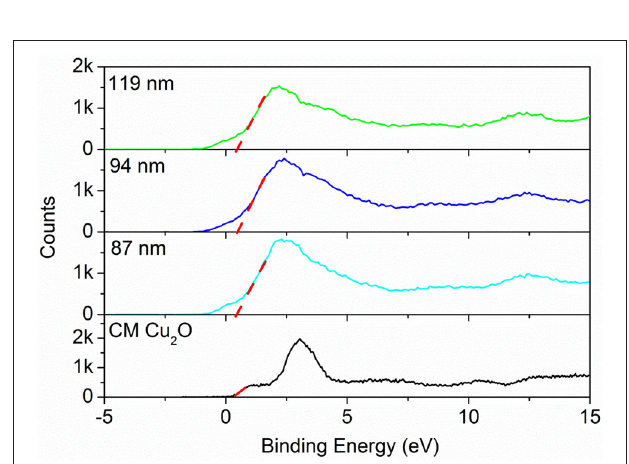
FIGURE 9 | Valence band-XPS spectra of Au@Cu x O core–shell MPNSs with different diameters and commercial Cu 2 O.